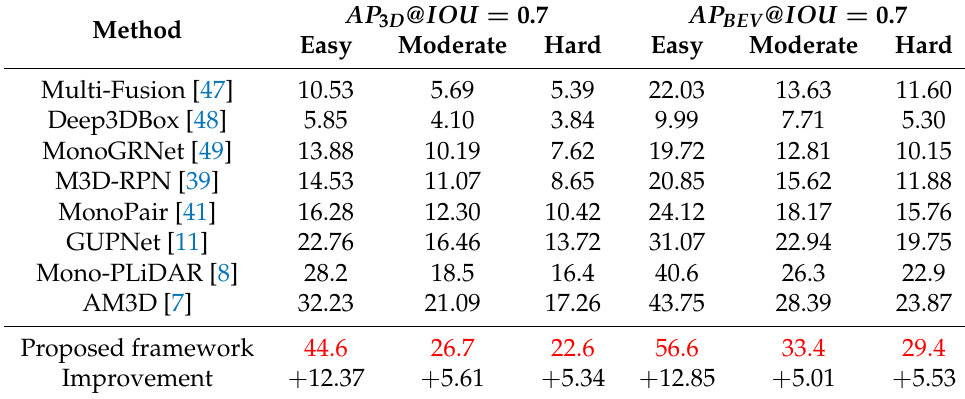
Table 2. Performance of 3D detection of the “car” category under AP @ IOU = 0.7 of the KITTI validation subset. We indicate the highest results with red.